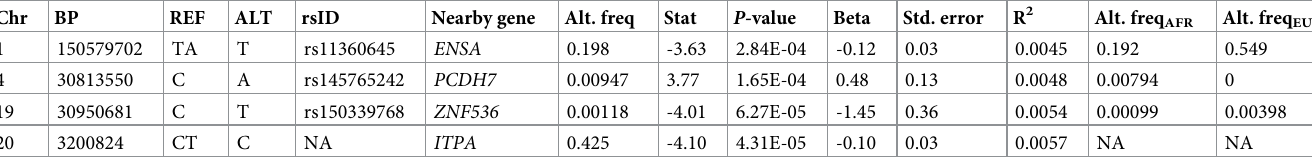
Table 4. Top associated SNPs within admixture mapping peak regions for DBP in the AADM